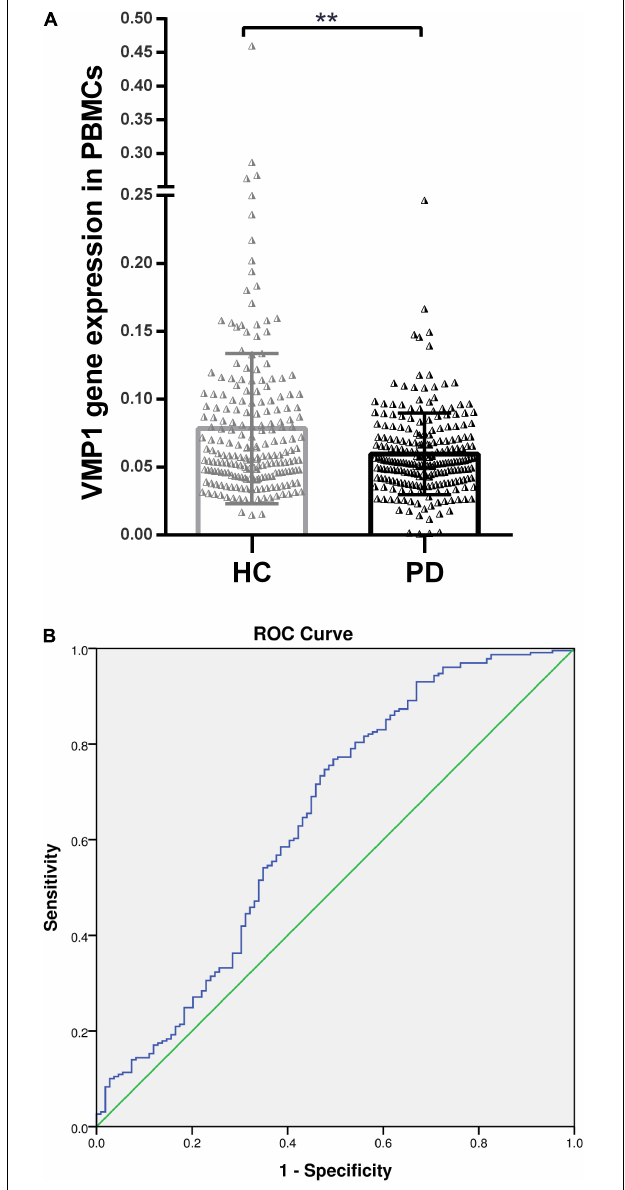
FIGURE 1 | Real-time quantitative PCR analysis for the VMP1 expression levels in PBMCs. (A) Scatter plots of VMP1 relative mRNA expression level in the PBMCs of HC ( n = 209) and PD ( n = 229). Horizontal bars represent mean and SE values. ** p < 0.01. (B) Receiver operation curve for VMP1 was (64.5%, 95% CI, 0.57–0.709) p <